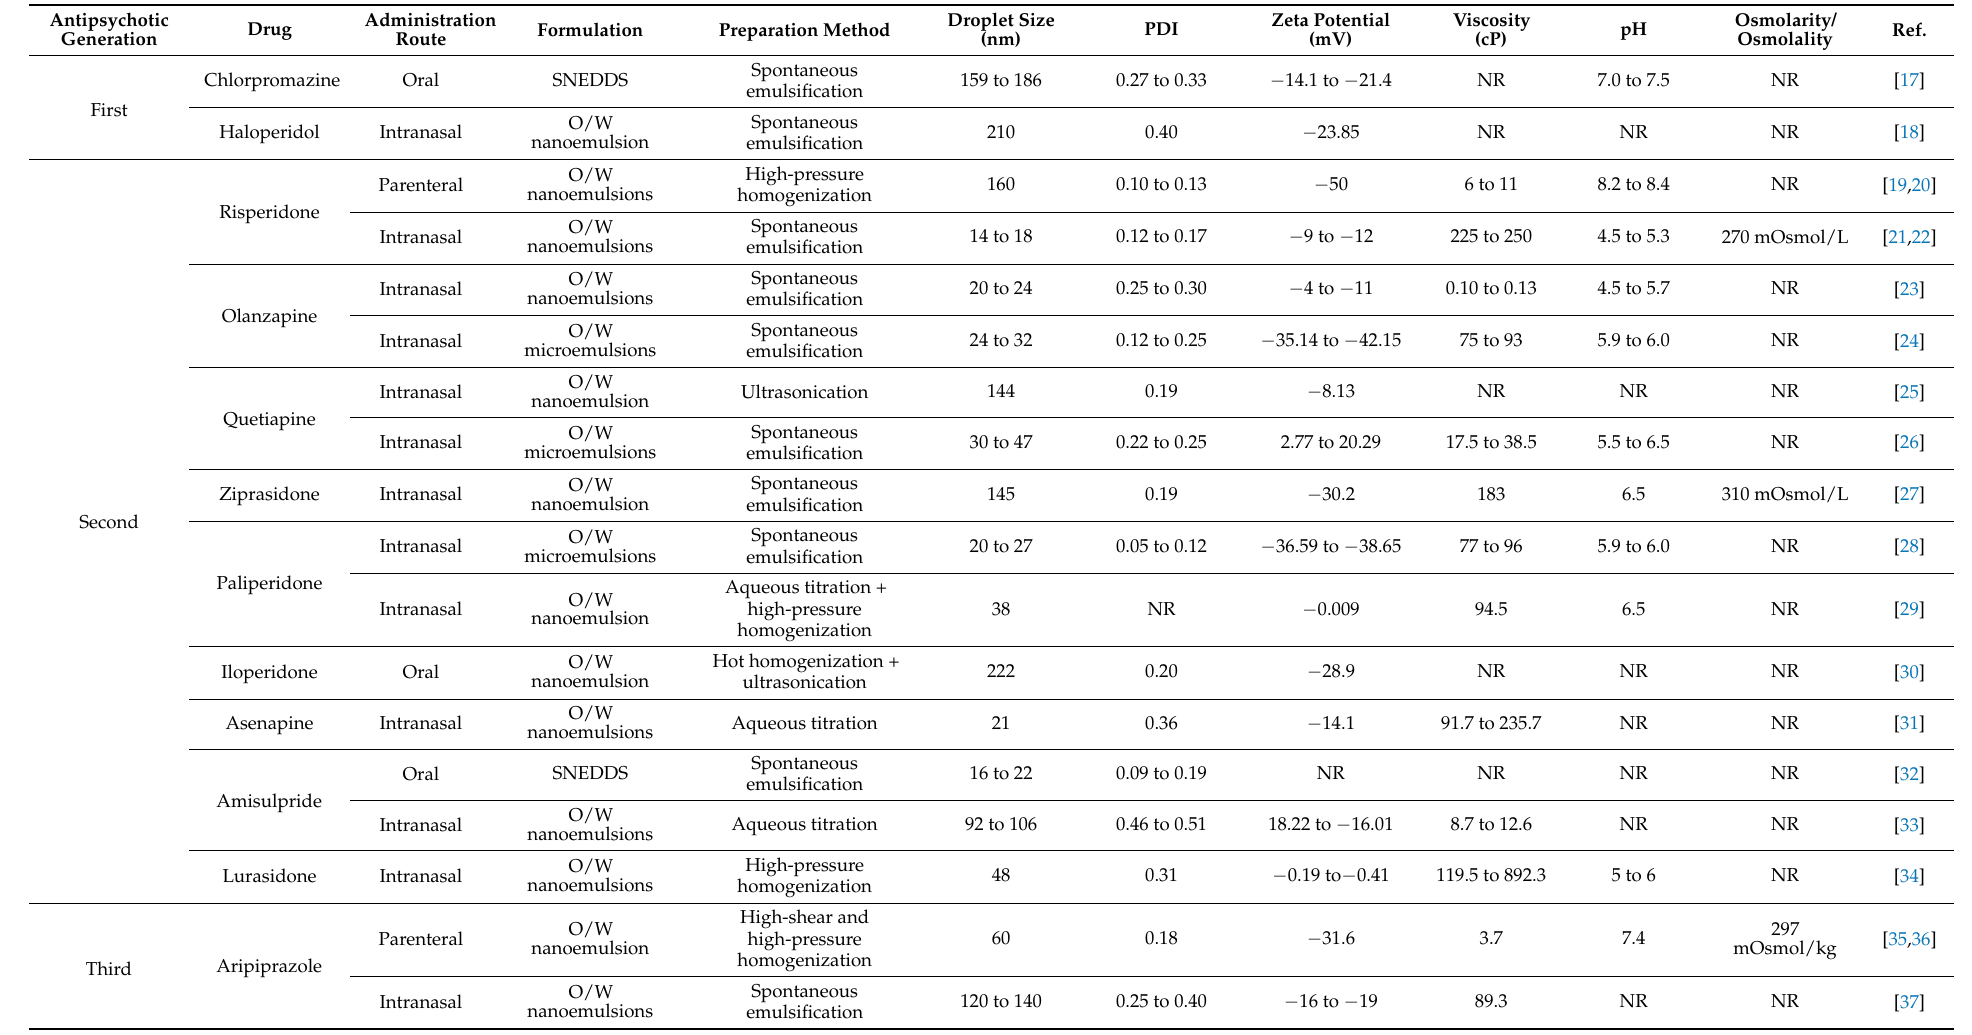
Table 1. Summary of the most relevant formulation parameters of the nanometric emulsions developed in the works included in this